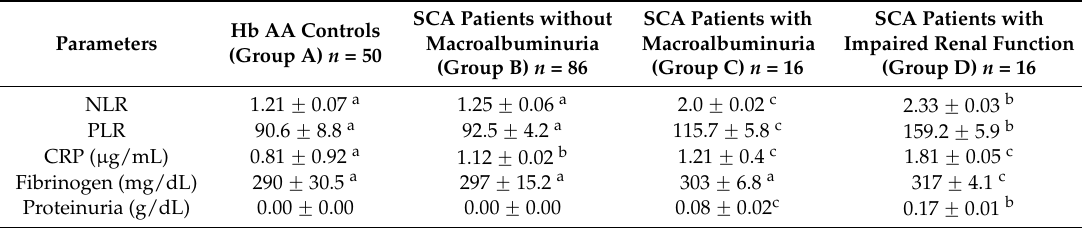
Table 2. Comparison of some inflammatory markers in SCD patients with macroalbuminuria and chronic kidney